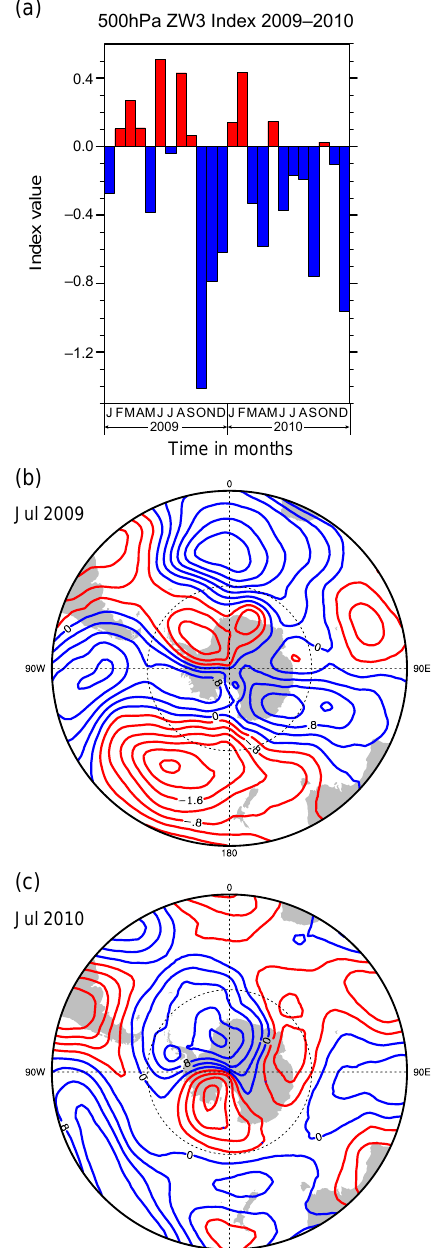
Figure 9. (a) Monthly mean zonal wave number 3 (ZW3) index for 2009–2010. (b) July 2009 500hPa geopotential height anomaly: mean July 2009 height minus long-term zonal mean height. (c) July 2010 500hPa geopotential height anomaly: mean July 2009 height minus long-term zonal mean